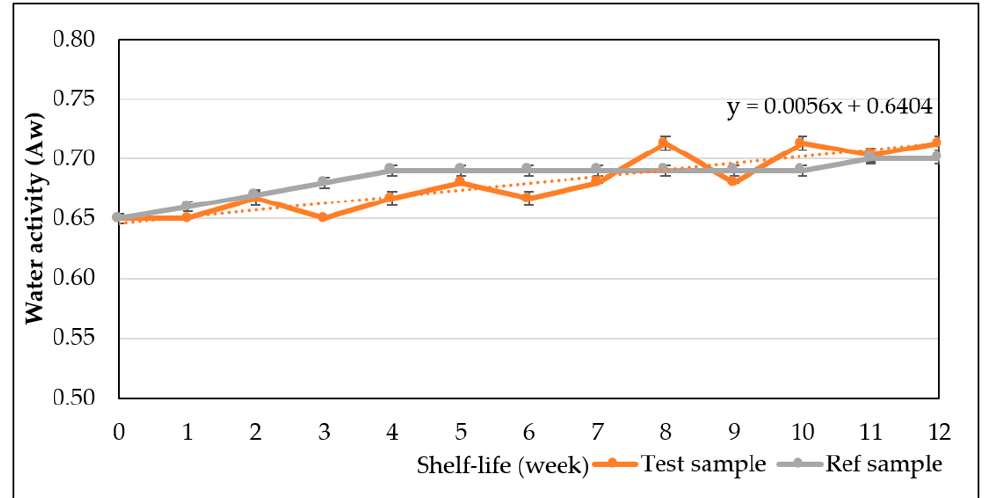
Figure 9. Water activity at 20 °C after various storage periods.